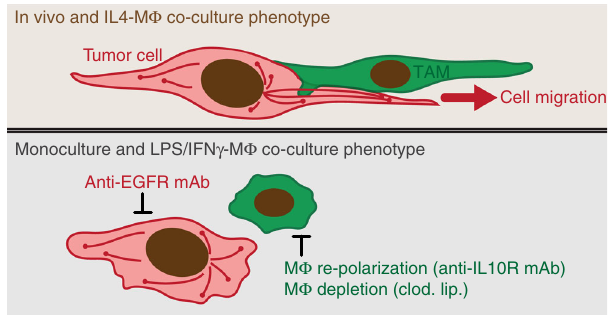
Fig. 10 Summary schematic of TAM-dependent MT dynamics in cancer cells. (Top) Tumor cells in vivo exhibit high MT coherence and orientation along the major length axis of elongated, migrating cells. In vitro, cancer cells display this phenotype upon co-culture with M2-like IL4-M Φ . (Bottom) The IL4-M Φ co-culture phenotype depends on cell signaling pathways in both tumor cells and M Φ , including EGFR on tumor cells, and pathways known to in fl uence M Φ polarization including PI3K γ and IL10R. In vivo, treatment with an IL10R-neutralizing antibody reduces MT coherence and orientation in neighboring cancer